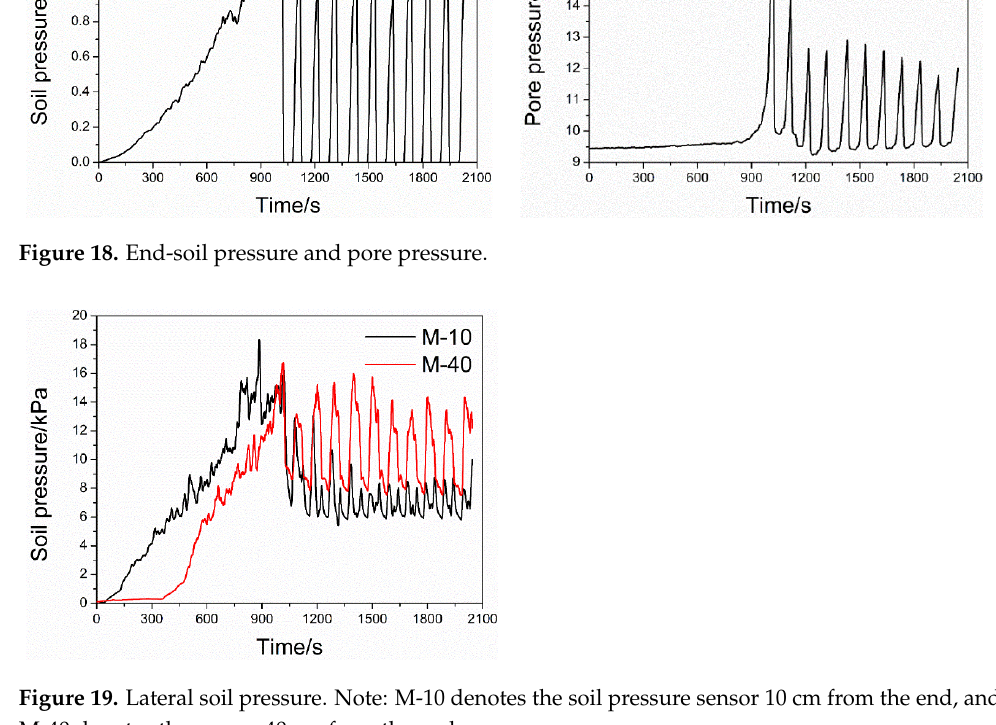
Figure 18. End-soil pressure and pore pressure.